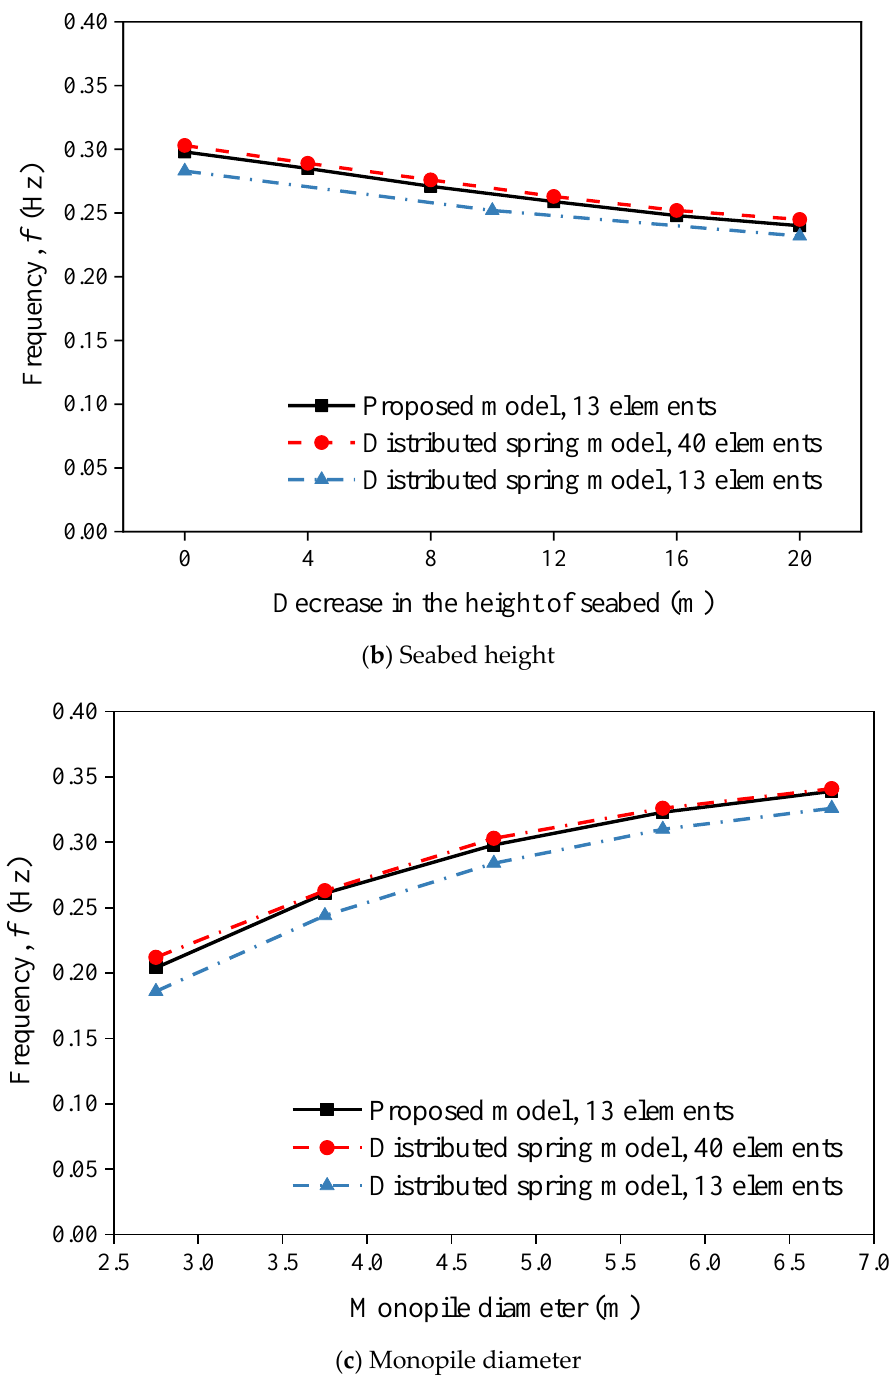
Figure 7. Comparisons of natural frequency between two modelling methods with the variation of OWT parameters.